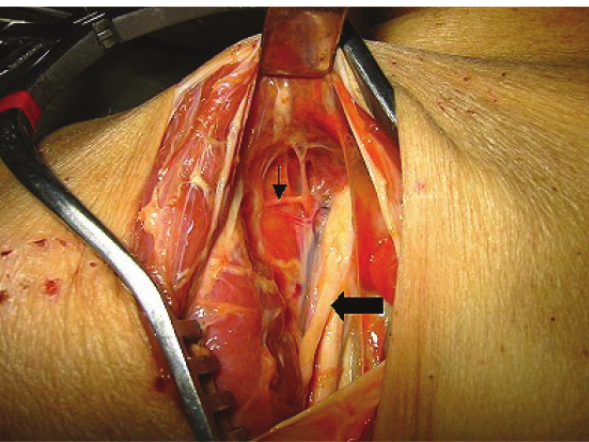
Figure 1 - Distribution of the distances (mm) of the site of entry of the musculocutaneous nerve into the coracobrachial muscle, in relation to the apex of the coracoid process (CP)